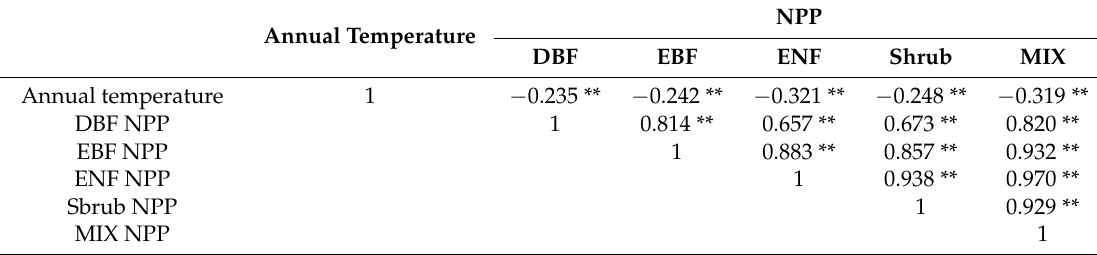
Table 7. Pearson correlation analysis between NPP of forest types and annual mean temperature in TGR.